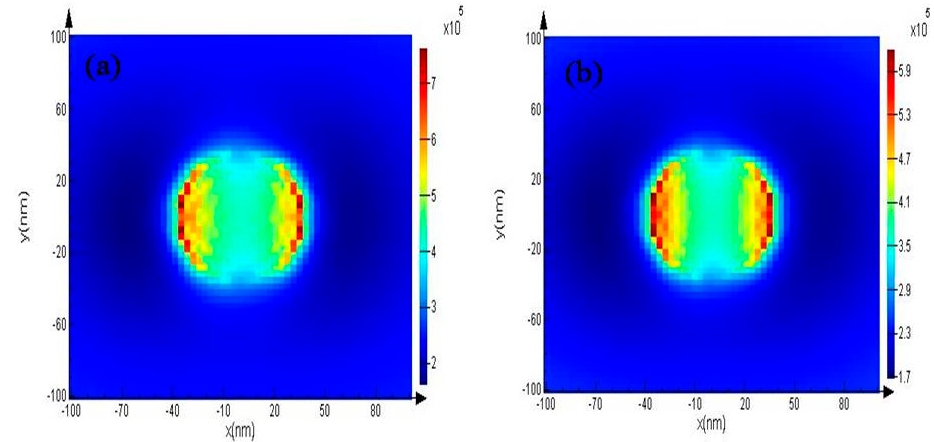
Figure 11. ( a ) current induced on GAG by 600 nm light wave by FDTD simulation; ( b ) The current induced on GA by 600 nm light wave by FDTD simulation.